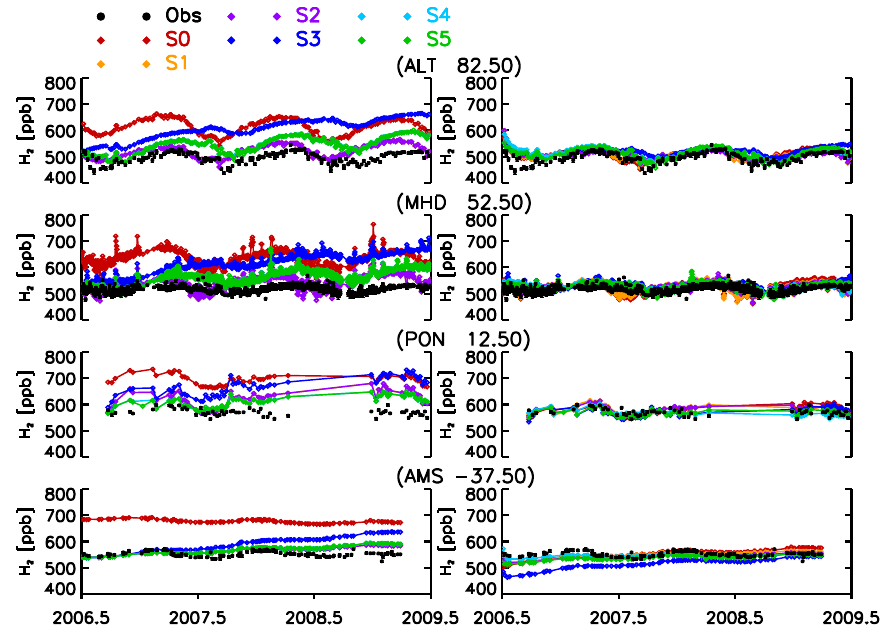
Fig. 5. H 2 mixing ratios at Alert, Mace Head, Pondichery and Amsterdam Island. Black filled circles plot the observations, diamonds, simulated mixing ratios. Each scenario is represented by a different color, S0 and S1 in a red color scale, S2 to S4 in a blue color scale and S5 in green. On the left panel, the prior simulations and on the right panel, the posterior simulations.